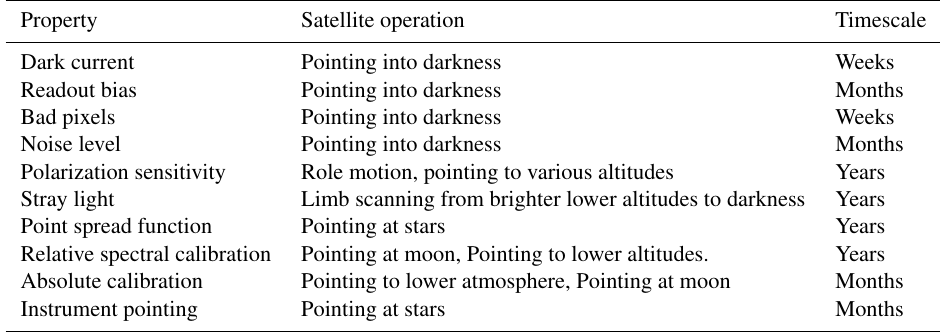
Table 7. Properties of the MATS limb instrument that need to be characterized during the mission. Property Satellite operation Timescale Dark current Pointing into darkness Weeks Readout bias Pointing into darkness Months Bad pixels Pointing into darkness Weeks Noise level Pointing into darkness Months Polarization sensitivity Role motion, pointing to various altitudes Years Stray light Limb scanning from brighter lower altitudes to darkness Years Point spread function Pointing at stars Years Relative spectral calibration Pointing at moon, Pointing to lower altitudes. Years Absolute calibration Pointing to lower atmosphere, Pointing at moon Months Instrument pointing Pointing at stars